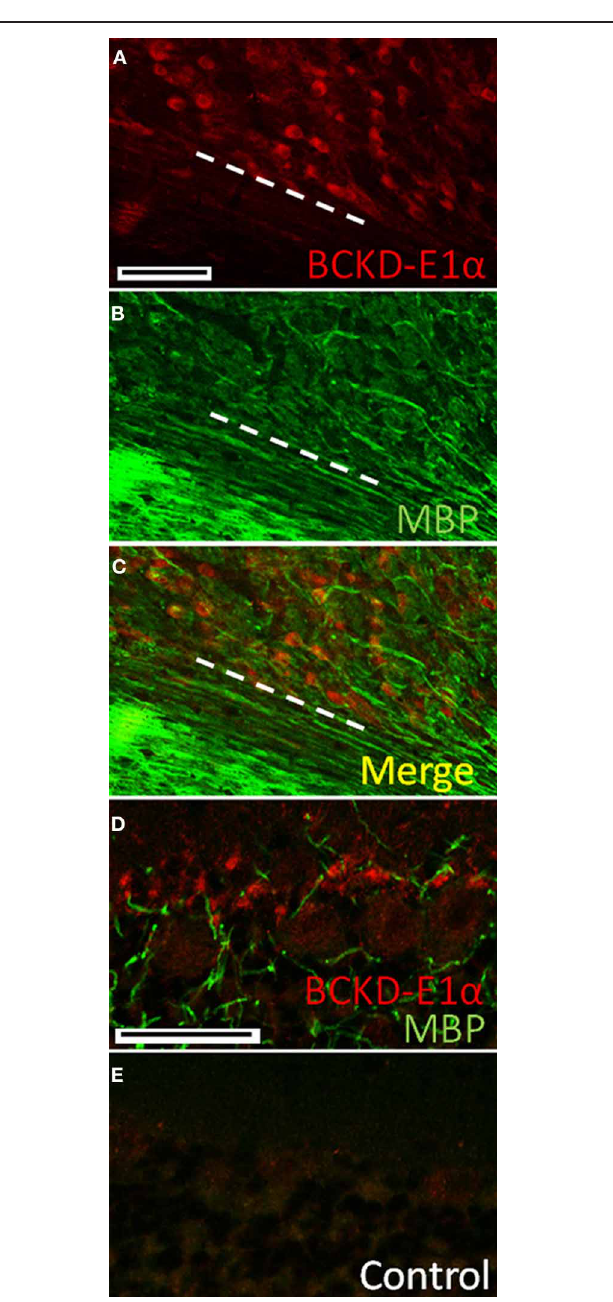
FIGURE 6 | Immunolocalization of BCKDC in deep cerebellar nuclei and white matter. (A) Labeling for BCKDC is strong in the cell bodies of neurons of the deep cerebellar nuclei. Dashed white line marks the border between the nucleus and an unlabeled white matter tract. (B) Immunolabeling for myelin basic protein (MBP), a marker for myelin and oligodendrocytes, in the same section as in panel A . (C) Merged image of panels A and B . There is virtually no co-labeling of cells for BCKDC and MBP. (D) Co-label of the Purkinje cell layer for BCKDC and MBP. Structures labeled for BCKDC are not labeled for MBP, indicating that they are not oligodendrocytes. (E) Control section showing the Purkinje cell layer of a section incubated with secondary antibodies only. The image was obtained using the same microscope settings, and processed in the same way as the image in panel A . Scale bars: (A–C) 100 μ m. (D,E) 50 μ